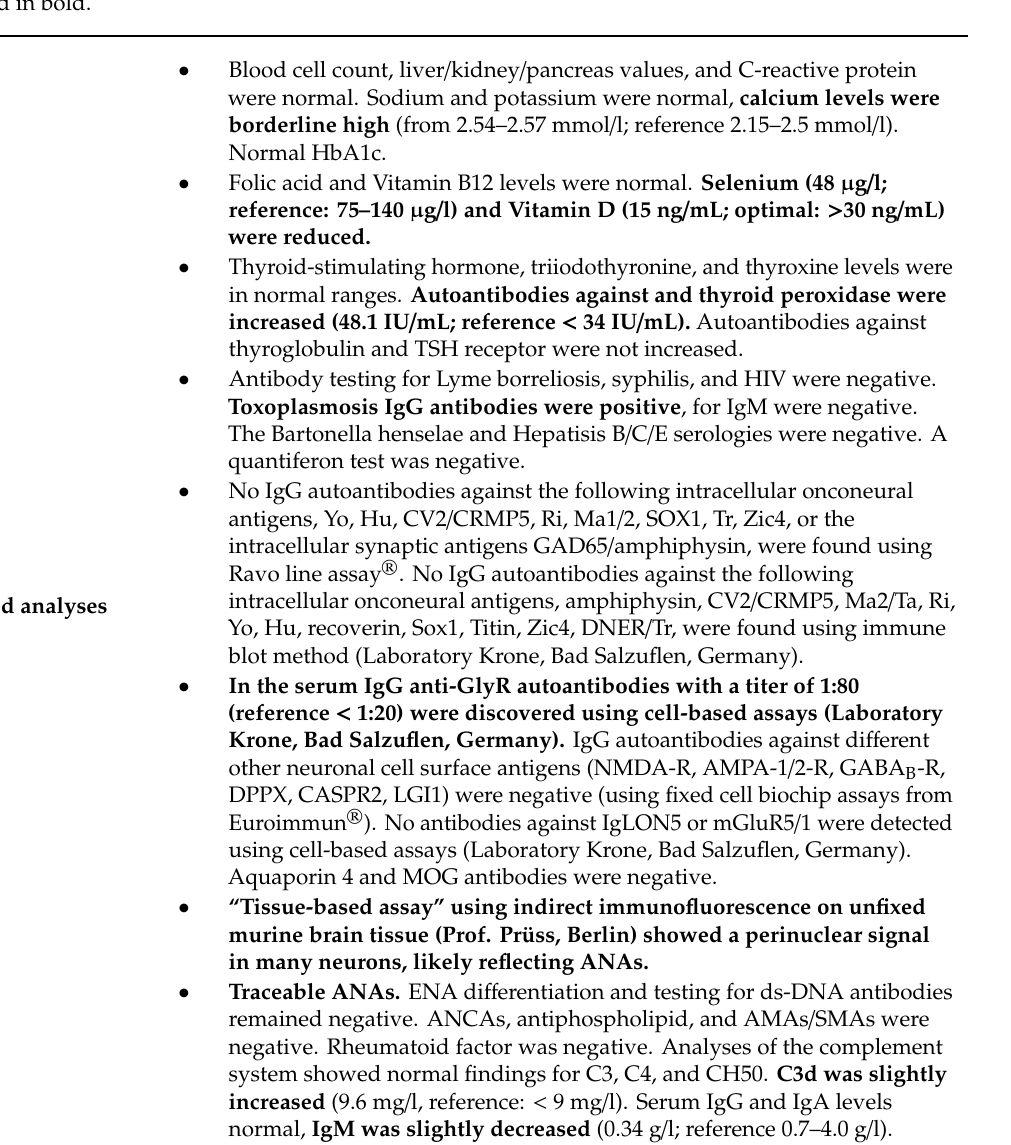
Figure 3. [ 18 F]fluorodeoxyglucose positron emission tomography (FDG PET; upper panel) and [ 123 I]FPCIT single-photon emission computed tomography (FPCIT SPECT; lower panel). The FDG PET revealed moderate bilateral hypometabolism of the frontal lobes, midbrain (see medial view), and, to a lesser extent, the caudate nuclei as well [upper row: transaxial FDG PET images, voxel-wise FDG uptake normalized to whole brain uptake; lower row: 3D surface projections of regions with decreased FDG uptake, color-coded Z-score compared to age-matched healthy controls [24]]. FDG PET of the brain was performed in addition to the whole-body scan at 50 min after injection of 348 MBq FDG (Vereos Digital PET / CT, Philips Healthcare, Eindhoven, The Netherlands). The FPCIT SPECT showed a severely reduced dopamine transporter (DAT) availability in both striata in the patient (left) compared to normal DAT binding in a healthy control (right), indicating pronounced nigrostriatal degeneration. FPCIT SPECT was performed 3 h after injection of 183 MBq FPCIT (Intevo SPECT / CT, Siemens, Erlangen, Germany; shown are parametric maps of the distribution volume ration ( DVR ) using the occipital cortex as reference without DAT binding). Abbreviations: R, right; l, left. Table 1. Diagnostic findings approximately three years after symptom onset. Abnormal findings are marked in